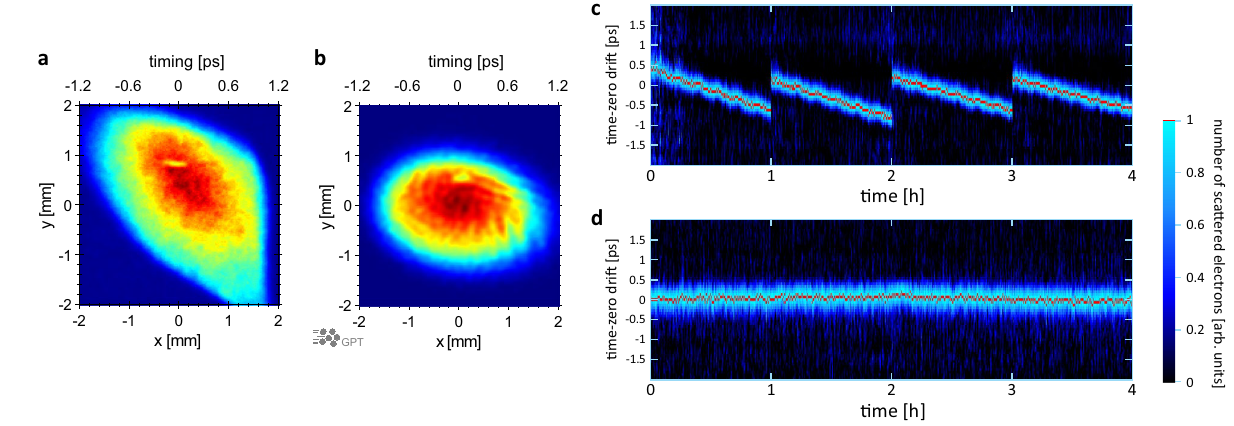
Figure 5. Time-zero drift measurement. ( a , b ) Images of an electron pulse on the fluorescent screen with the imaging lens obtained via experiment ( a ) and simulation ( b ). The electron lens relays the image 26 mm behind the compression point, where the electron pulse and laser pulse intersect, onto the fluorescent screen. The shadow observed at [ x , y ] = [0 mm, 0.8 mm] in ( a ) corresponds to the part that was scattered by the intense laser pulse. In ( b ), this shadow appears at [ x , y ] = [0 mm, 0.6 mm]. If the intersection time (interaction position) of the laser pulse and electron pulse deviates, this shadow moves in the x -axis direction. Hence, the x -axis direction in this figure corresponds to the time-zero drift. The drift was calibrated by moving the delay stage, and the time scale is shown at the top of ( a ) and ( b ). ( c , d ) Time-zero drift measurements over 4 h, showing the electron density distribution in the x -axis direction. The region containing scattered electrons appears in blue, and the red line indicates the peak. ( c ) shows the case where the system was not subjected to temperature control; owing to the excessive drift, we moved the delay stage every hour to correct the position. ( d ) shows the results when the system was subjected to temperature control using a chiller. As shown in Fig. 6a, the RMS timing jitter was 14 fs.